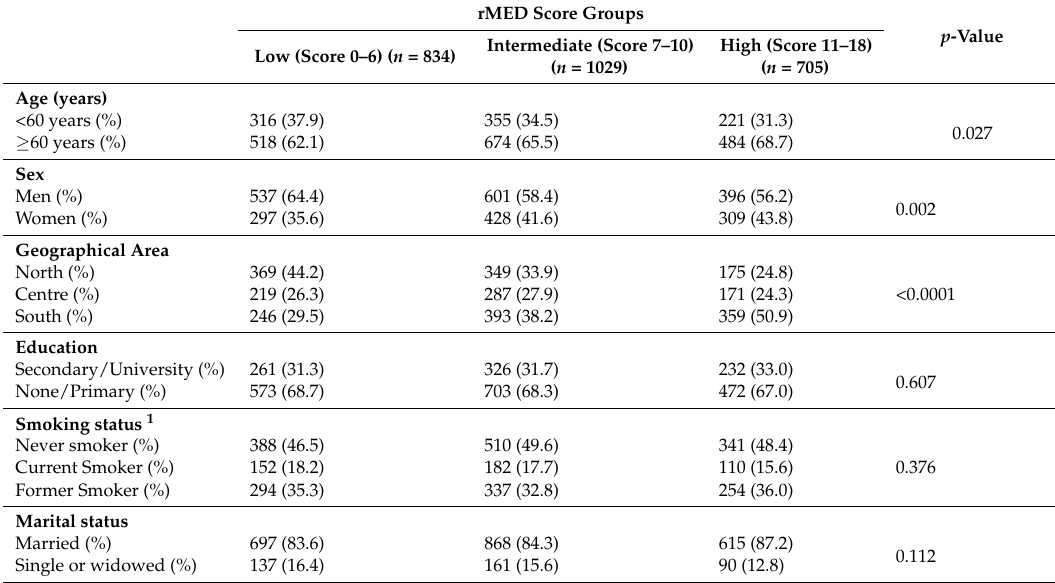
Table 1. Characteristics of the study participants by rMED score